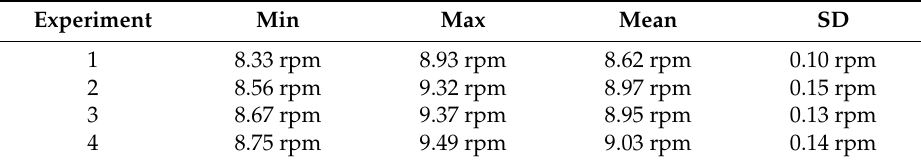
Figure 10. Blue refers to normalized interpolated sinusoidal wave derived from the rotary encoder data. Red refers to average of 200 SP recordings. The error bar at each point refers to the maximum difference of the SP recordings from the interpolated wave at that point. Maximum upper error is 15.8% and maximum lower error is 17.45%. Table 3. Statistical Parameters of Motor Speed.